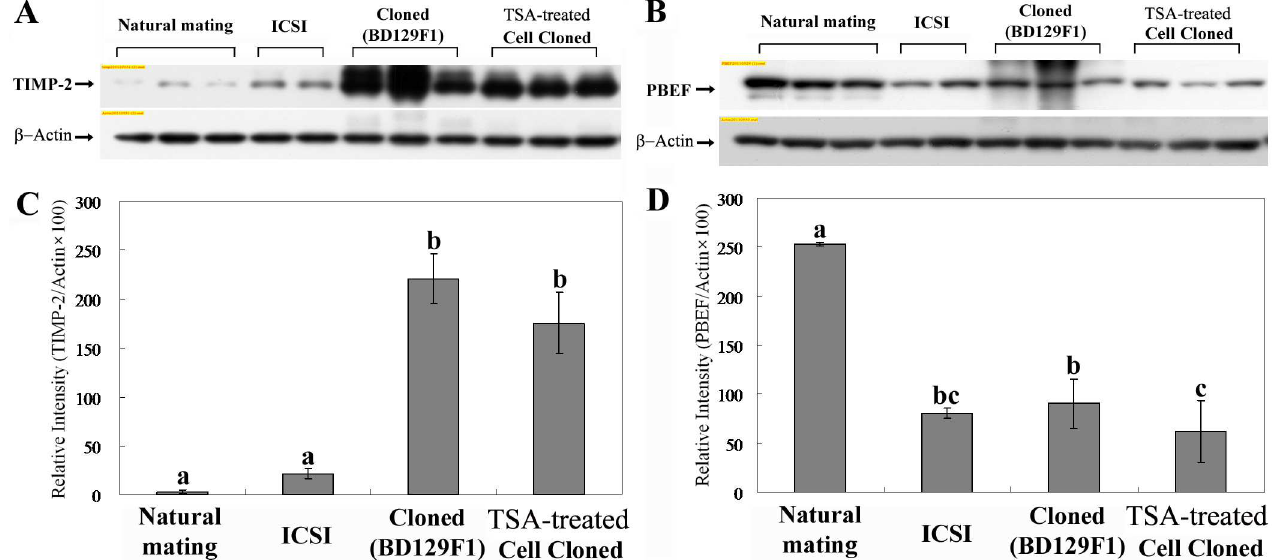
Fig 2. Western blot analyses of TIMP-2 and PBEF expressionlevels in in NM control, ICSI-derived, cloned, and TSA-treated cloned placentae. (A) Representative bandsdetected with anti-TIMP-2 and anti- β -actinantibodies. (B) Representative bandsdetected by anti-PBEF and anti- β -actin antibodies.(C, D) Protein levels were subjectedto densitometric quantification followedby normalization against the proteinlevel of β - actin. Four replicateswere performed. The mean of expressionlevels with different superscripts (a-c) differ significantly (P < 0.05). Error bars show the standarderror (SE).